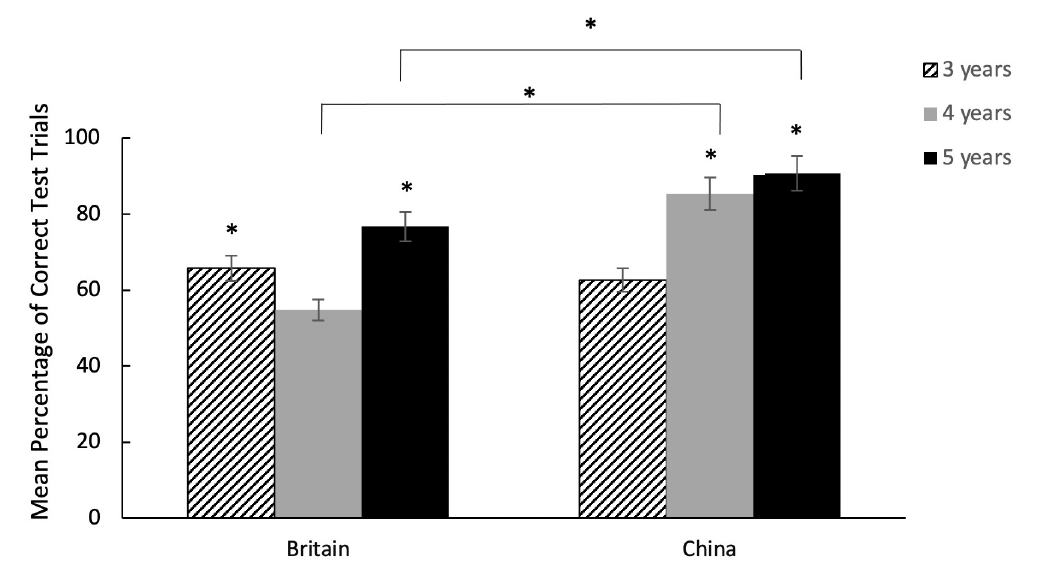
Fig 5. Mean percentage of correct test trials across condition by age groups in Experiment 2. � indicates performance above chance level (p < 0.05), error bars indicate standard errors. Chinese 4- and 5-year-olds outperformed British 4- and 5-year-olds respectively, with no differences in performance between the 3-year-olds, indicated by the significance lines. Data on the British children has been published in Miller et al. [52].